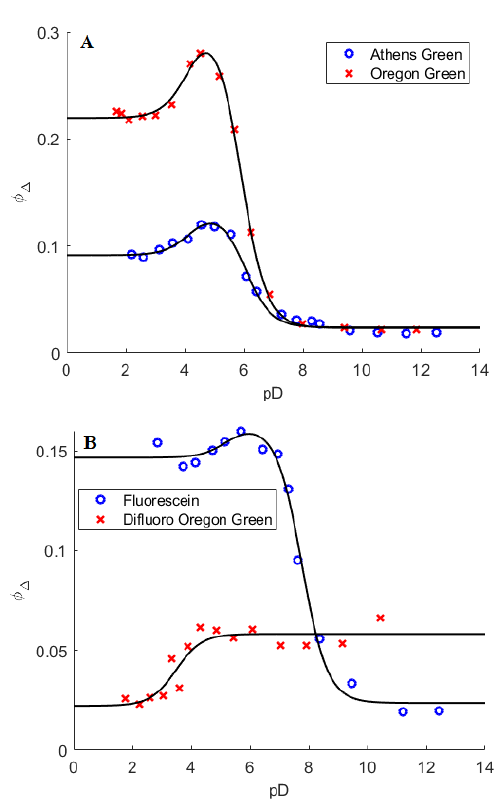
Figure 7. The O 2 (a 1 Δ g ) quantum yield, φ ∆ , plotted as a function of the pD in air-saturated D 2 O-based solutions for ( A ) Athens Green and Oregon Green, and ( B ) fluorescein and difluoro Oregon Green. The solid lines are numerical fits to Equation (1). Differences in p K a and φ ∆ values are apparent in these plots, and the pertinent numbers are shown in Table 4. For a given data point, the error is approximately 10% of the value shown.